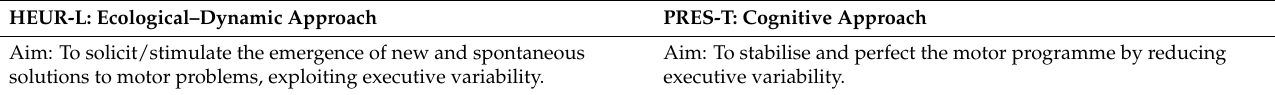
Table 1. Training-protocol example of two groups using two different teaching